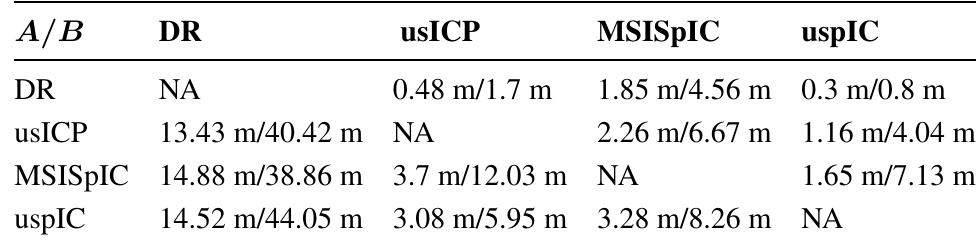
Table 2. Mean/maximum improvement, in meters, of method A with respect to method B. DR means dead reckoning.